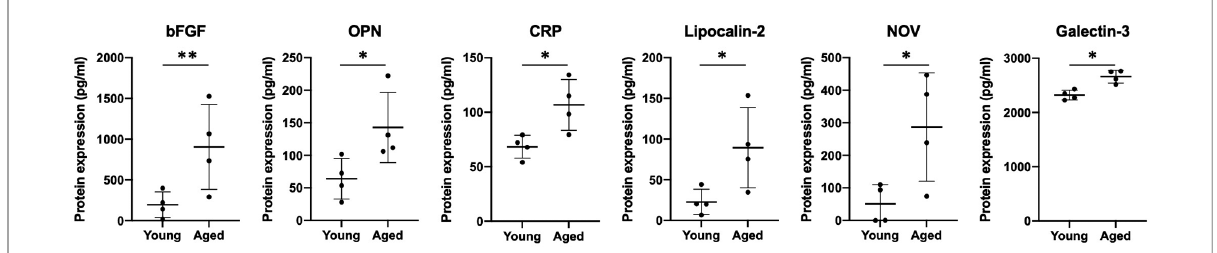
FIGURE 5 Cytokines displaying age-associated differential expression in murine epithelium-enriched tissue sheets. Dot plots display level of basic fi broblast growth factor (bFGF), Osteopontin (OPN), C-reactive protein (CRP), Lipocalin-2, Nephroblastoma overexpressed (NOV/CCN3) and Galectin-3 expression in epithelium-enriched tissue fraction from young or aged mice. Cytokine/soluble factor values were determined by RayBiotech Mouse Cytokine Array Q4000 with 75% – 100% of best con fi dence. Data are from an experiment including two groups: young ( n =4) and aged ( n =4) and presented as mean±SD. Statistical analysis was performed using two-tailed t -test (** p value <0.005; * p value<0.05).